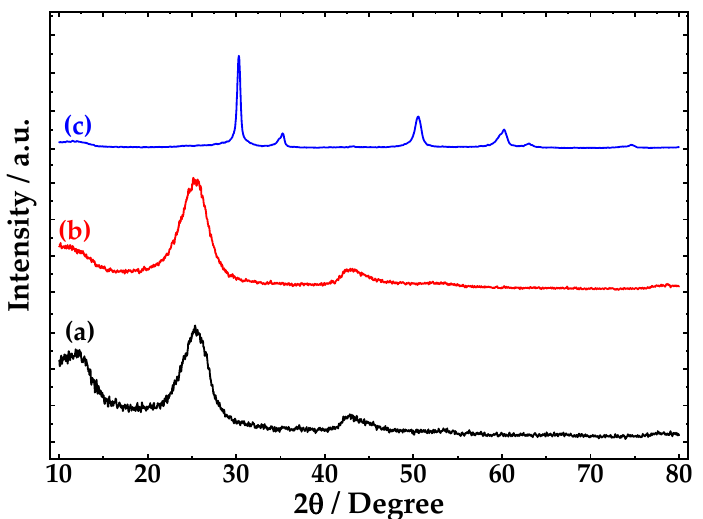
Figure 5. The zeta potential curve of ( a ) fCNTs and ( b ) ZrO 2 -fCNTs in an aqueous solution.